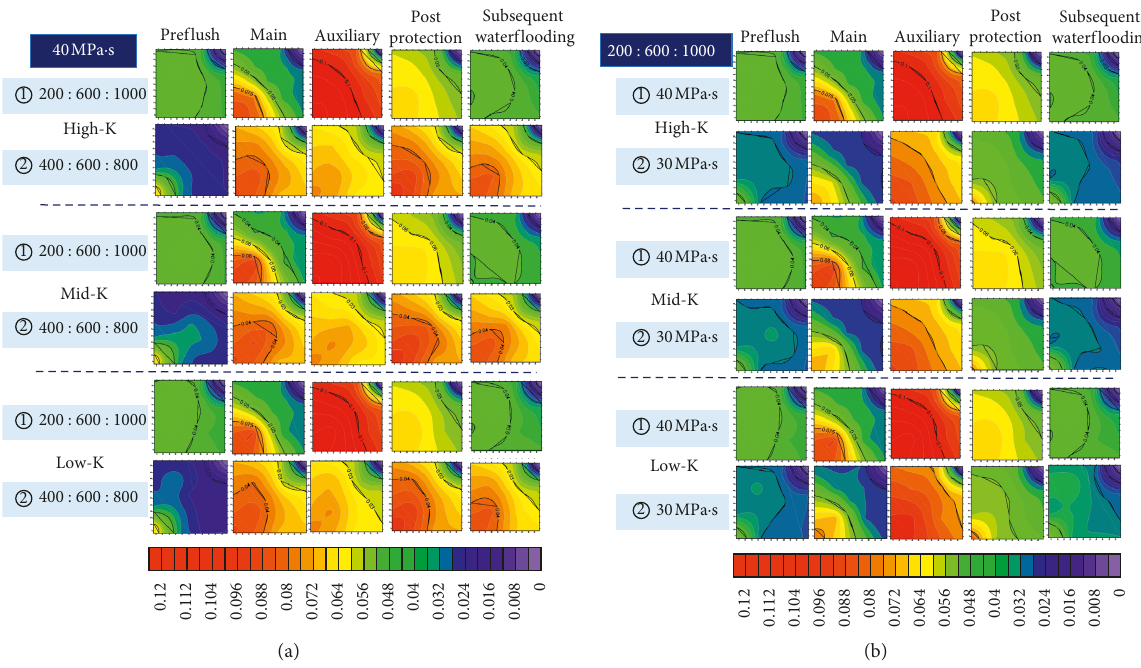
Figure 15: Two-dimensional pressure field of (a) different heterogeneities and (b) different viscosities.